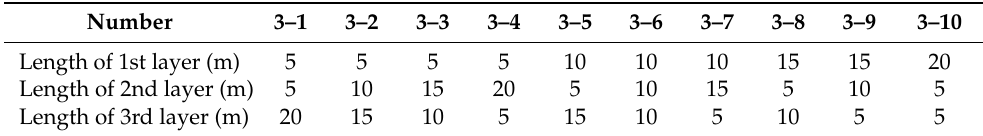
Table 3. Ten types of three layers.